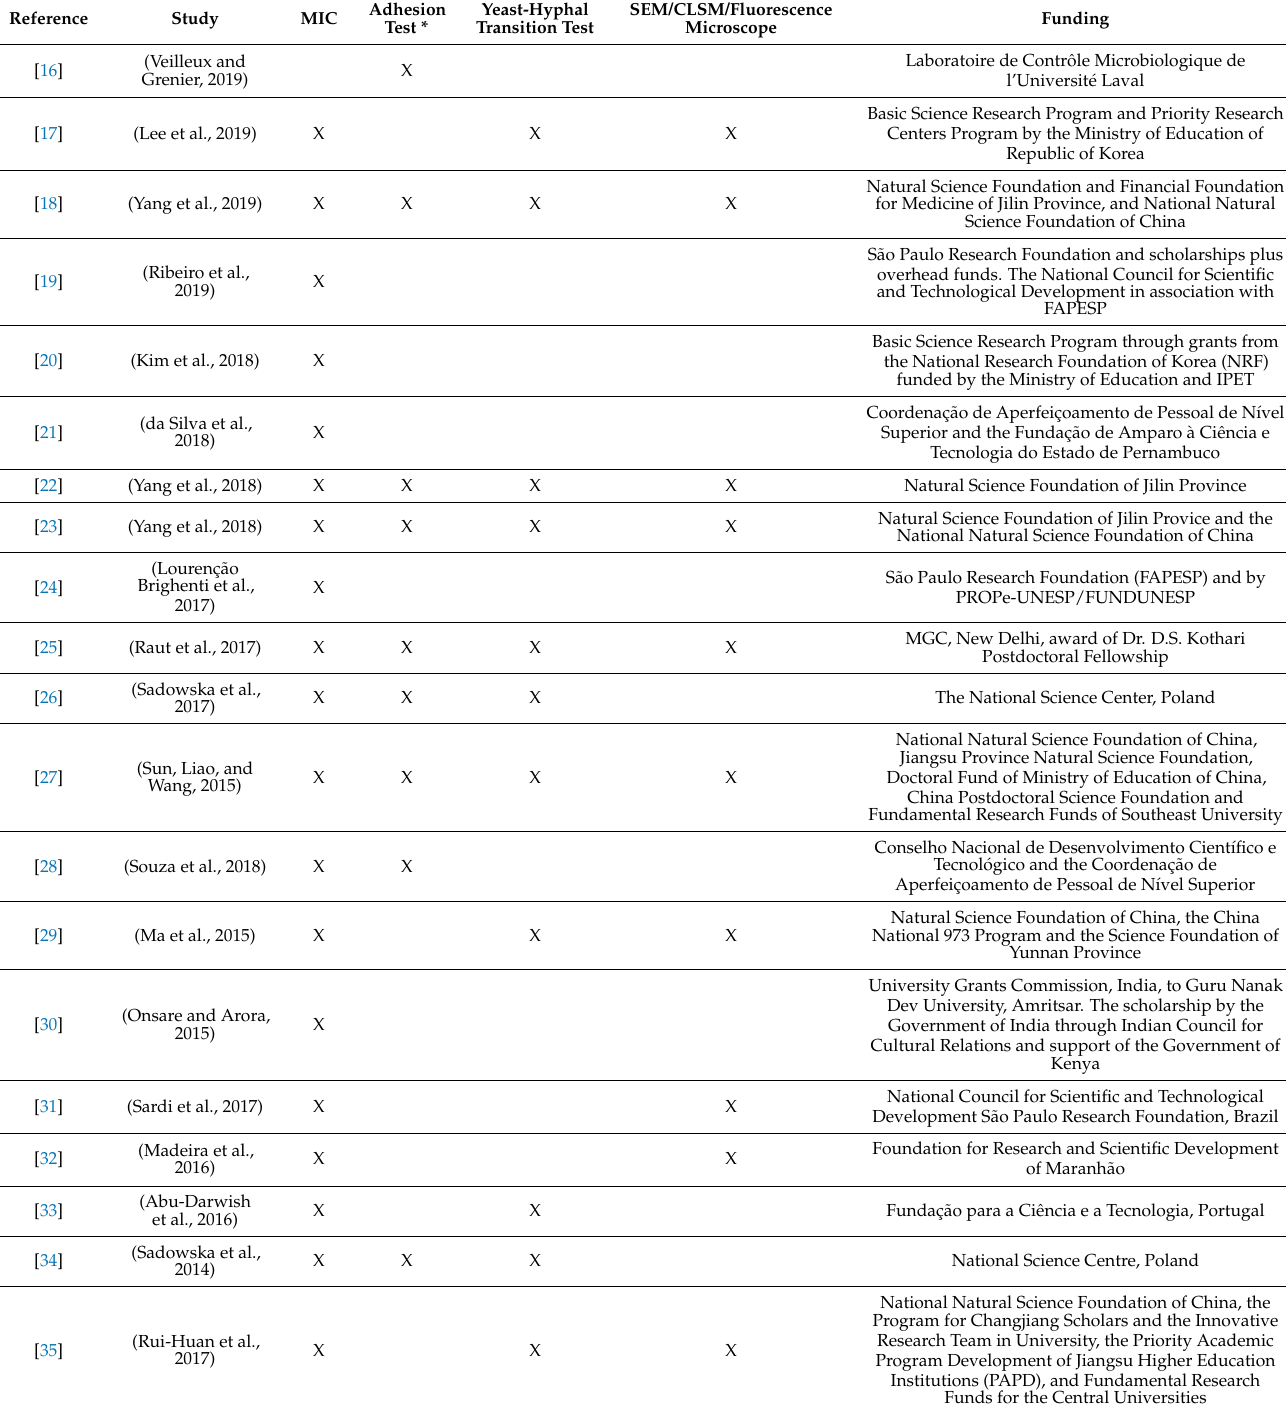
Table 1. Additional study variables to those included in the inclusion criteria and funding